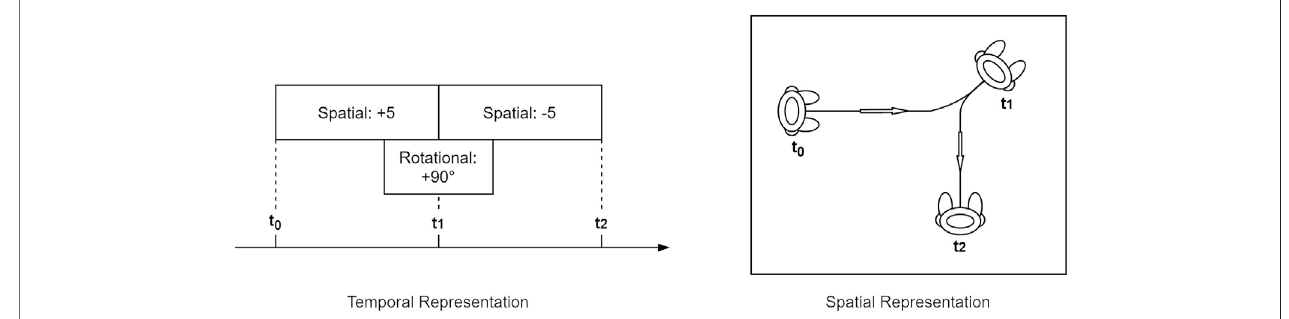
FIGURE2 | CombinationofSpatialandRotationalMovementintworepresentations.Left:Spatialmovementcanco-occurwithrotationalmovement.Differentdirections can be achieved by combining rotations with positive or negative spatial moves. Right: The result of parallel spatial and rotational movement is a curved walk. Here t 0 is the robot ’ s position prior to movement. t 1 is the point when the robot shifts from forward movement to backward movement, whilst completing half of the 90 degree rotation.